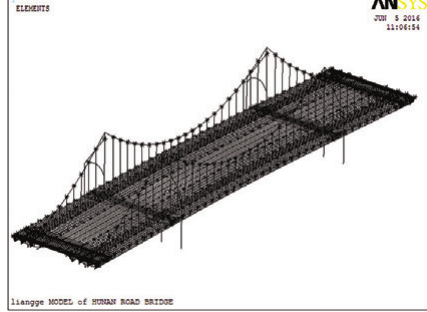
Fig. 6. Finite Element Model of Hunan Road